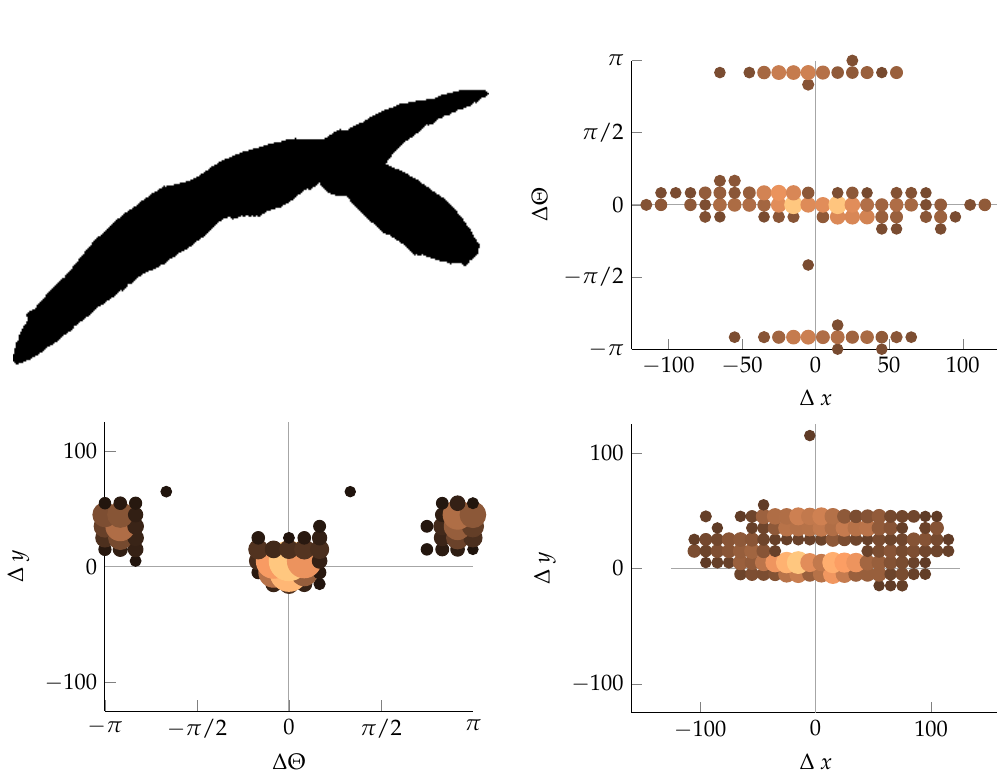
Figure B6. Monocot example